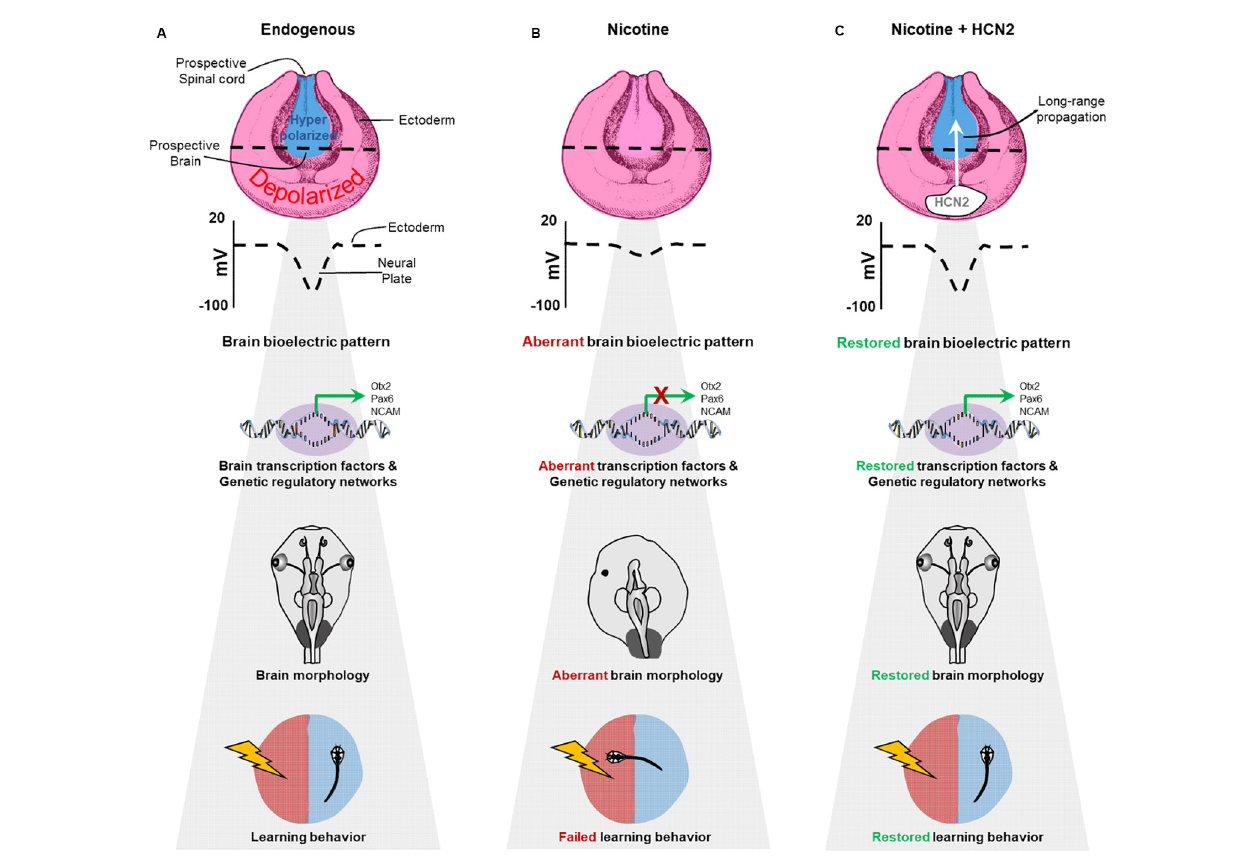
FIGURE 11 | Schematic model of bioelectric signaling in brain teratogenesis and long-range repair. (A) Our new data and those of previous studies (Pai et al., 2015b, 2018) show that the membrane voltage difference between the hyperpolarized neural plate and depolarized surrounding ectoderm is crucial for correct gene expression pattern, proper brain morphology, and normal learning behavior. (B) Embryonic nicotine exposure erases this crucial membrane voltage difference and leads to aberrant gene expression patterns, brain morphology defects, and impaired learning behavior. (C) Transplanting HCN2 channel tissue onto nicotine-exposed embryos is sufficient to restore the membrane voltage difference over long-range and rescue gene expression patterns, brain morphology defects and learning behavior in these